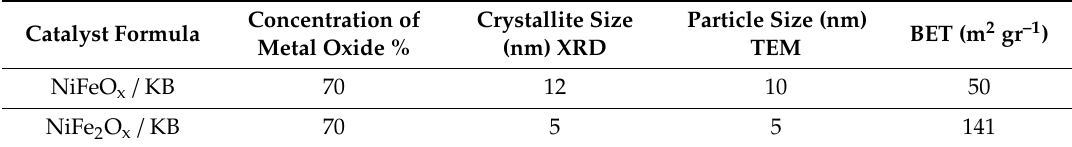
Table 1. Structural characteristics of the non-CRM Ni-Fe electrocatalysts.